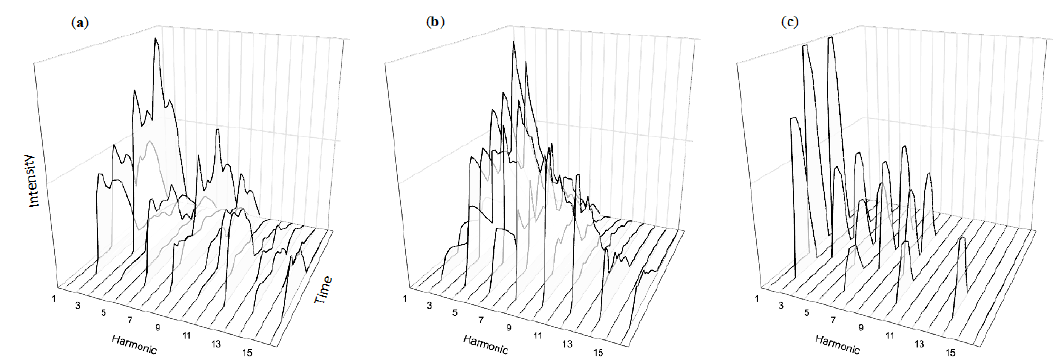
Figure 5. Three distinct renderings of a melodic alarm. The descending octave pitch sequence indicating power failure synthesized with either violin ( a ) or trumpet ( b ) sounds. These exhibit greater temporal complexity than industry standard beeps ( c ).